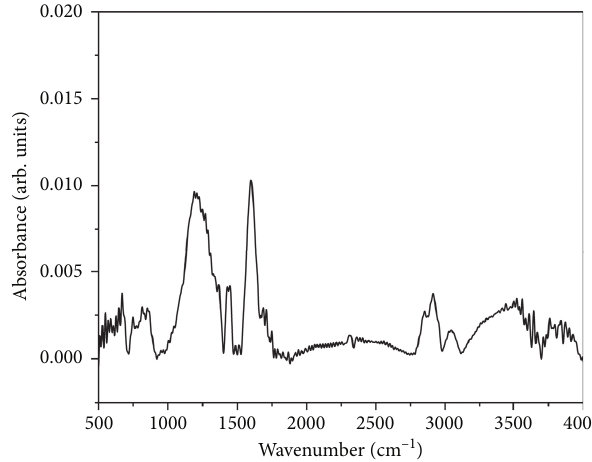
Figure 4: FTIR of bituminous coal